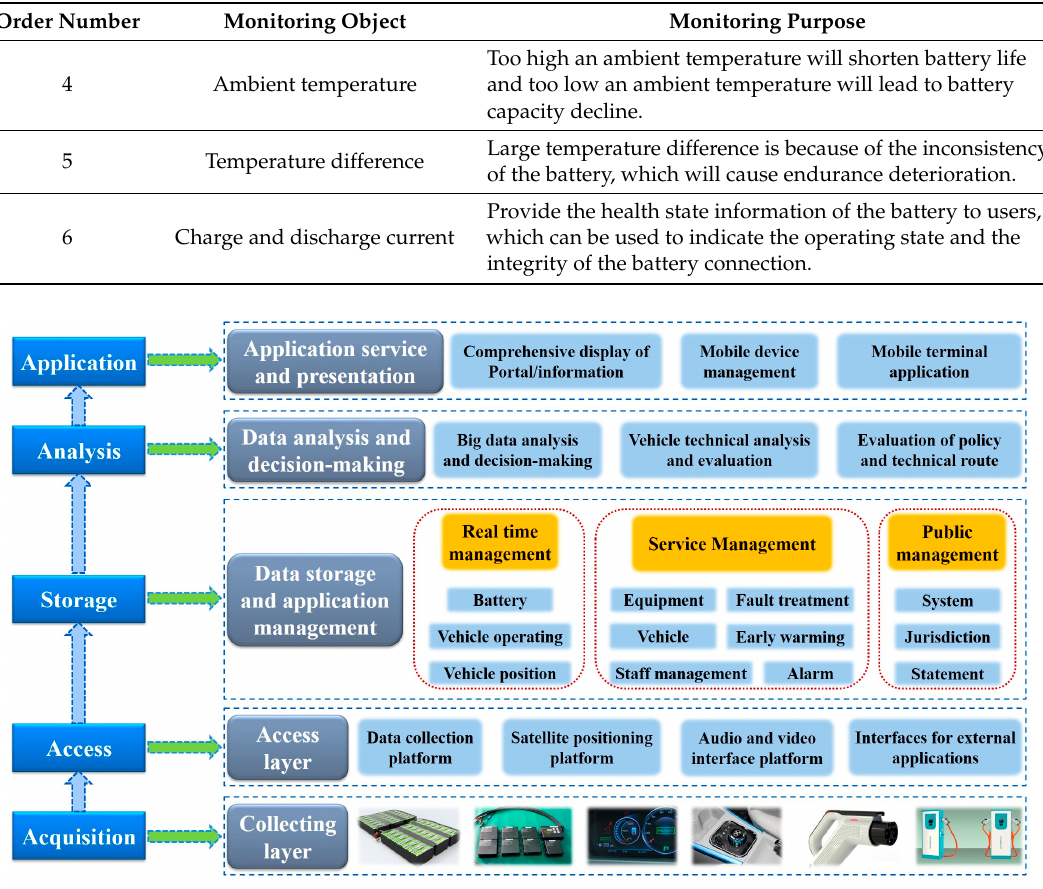
Figure 3. The logical topological management structure of the NSMC-EV.